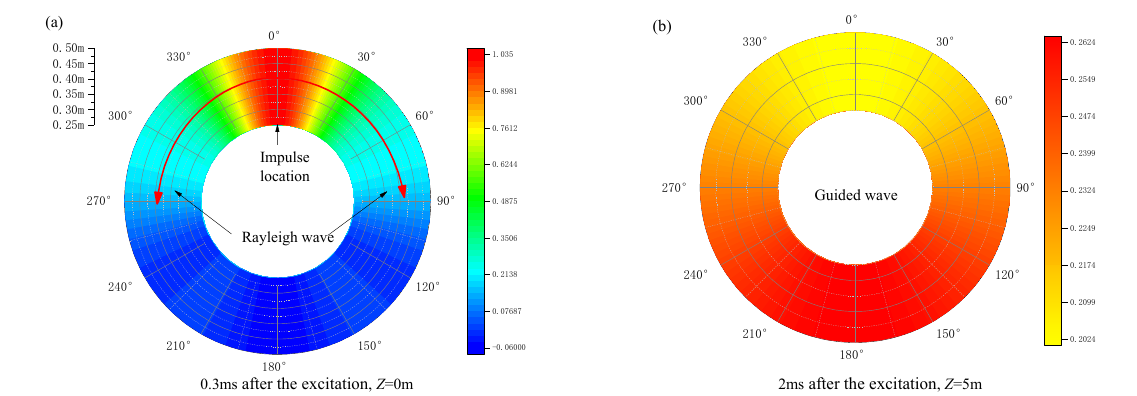
Figure 10. Formation of the high-frequency interference caused by radial transverse wave (repro- duced from Meng and Su (2022) [81]).